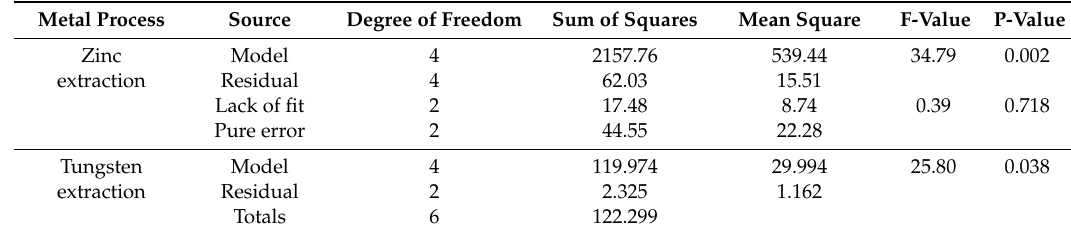
Table 7. ANOVA results of fitted models for zinc and tungsten extraction.